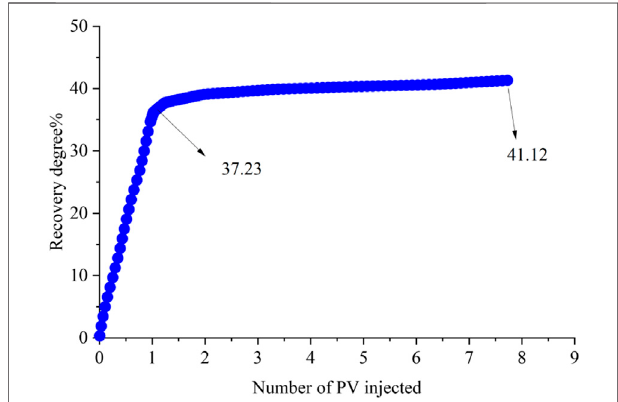
FIGURE 12 | Flow line of digital and analog fl ow and oil saturation.